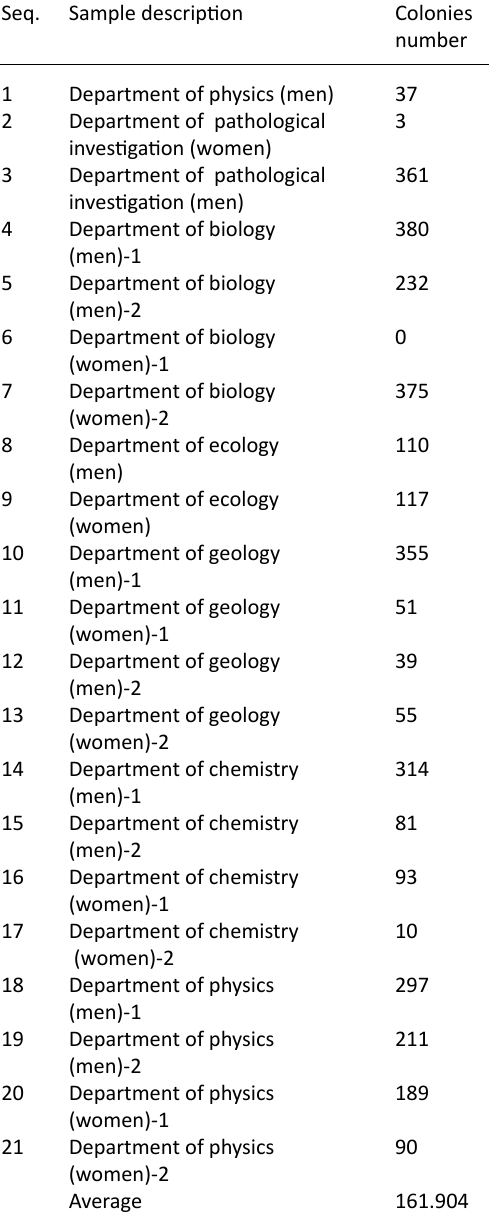
Table 4. Bacterial contamination of toilet doors handles